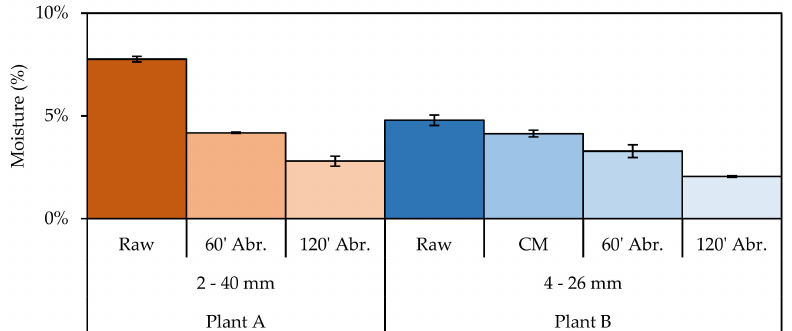
Figure 4. Moisture content of the raw samples from Plant A and Plant B, of the samples treated for 60 and 120 min abrasion (Abr.) time, and those treated with the concrete mixer (only Plant